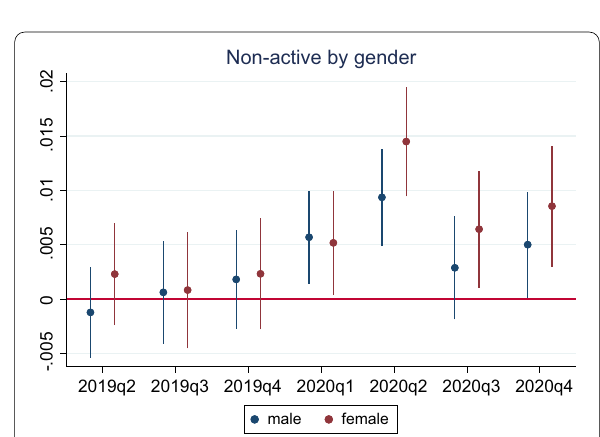
Fig. 5 Non-active Over Time for Men and Women. Notes Estimates from regression (3) of non-active dummy on quarterly dummies, run separately for men (blue) and women (red), with 95% confidence intervals. Regressions estimated with linear probability model, including random